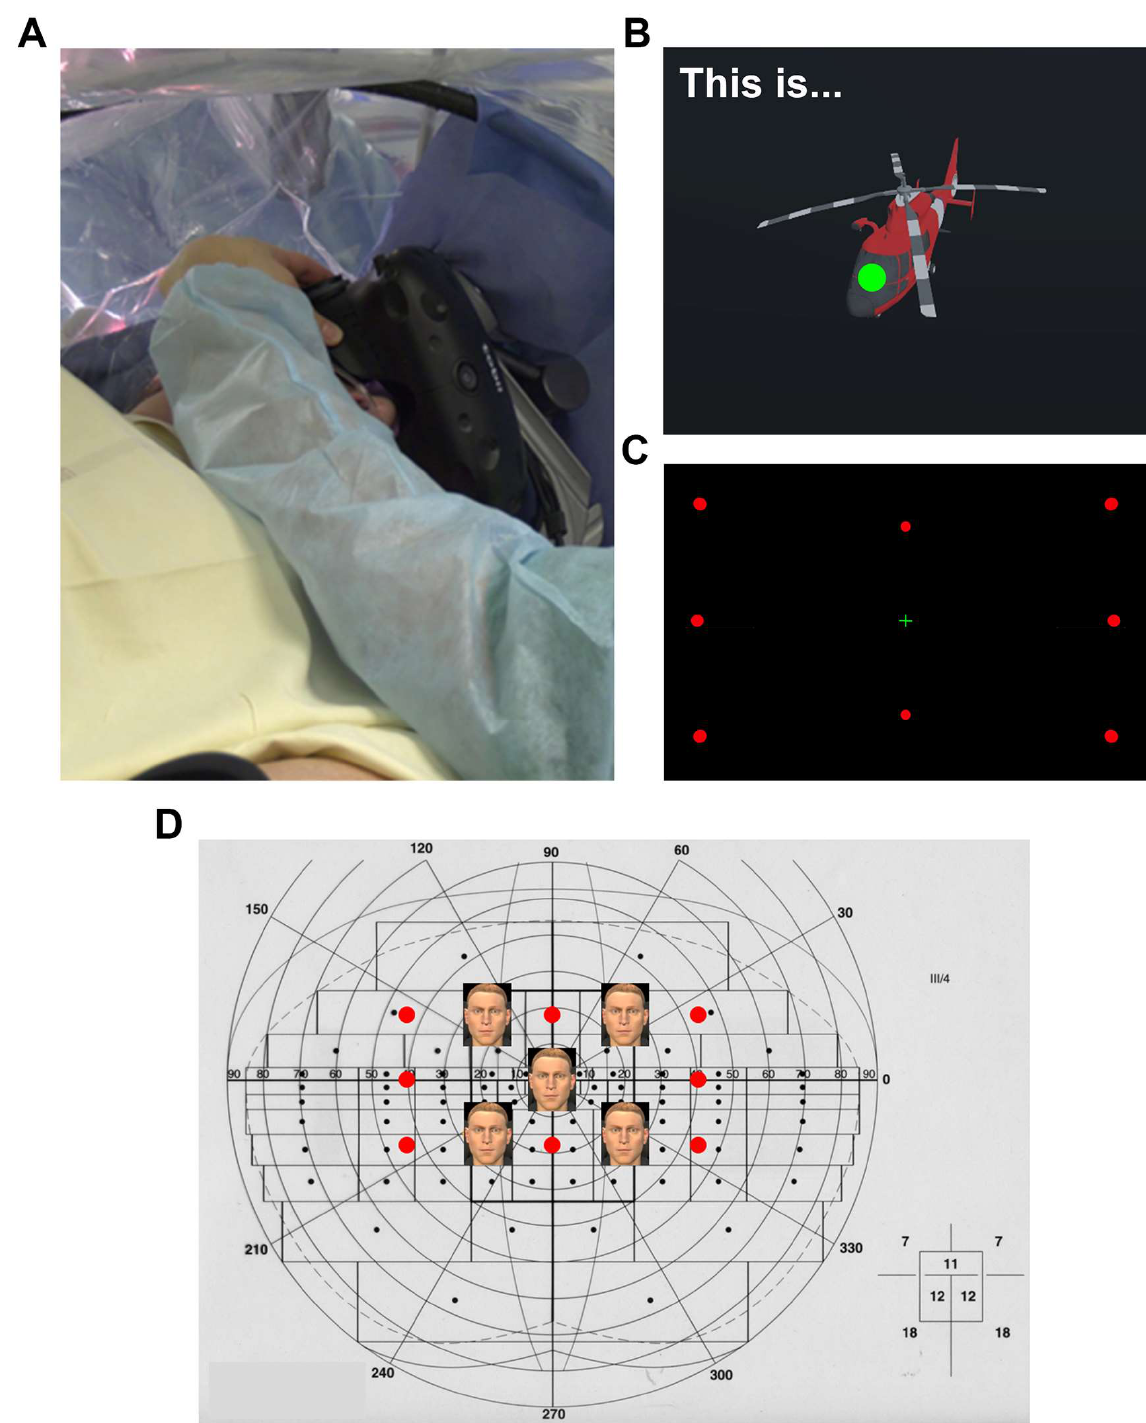
Figure 2. The VR-DO80 and VR-Esterman tests using the VRH combined with an eye-tracking device. ( A ) Patient wearing the VRH. ( B ) VR-DO80 naming task presented in 3D with the VRH. The green spot indicates the patient’s gaze. ( C ) VR-Esterman test exploring a visual field of 80° with 8 possible red dots on a black background around the green central visual axis. ( D ) The same dots projected on an Esterman grid on which the five avatars of the VR-TANGO are also positioned.